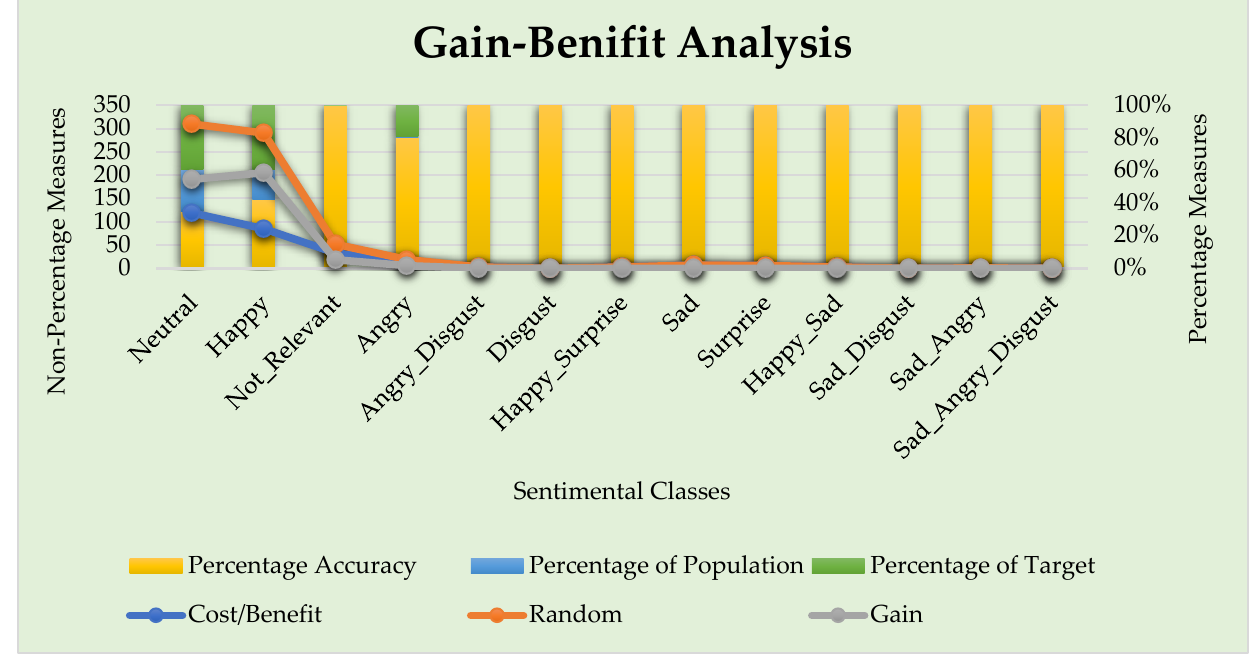
Figure 12. Graphical representation of cost/benefit (tetrad feature selection techniques). Table 12 first part indicates the threshold plot curve ratio between the sample size (X) and the true positive rate (Y) from 0 to 1. The second part indicates the cost/benefit curve between the sample size (X) and the cost/benefit (Y) clusters with an acceptable accuracy rate. In the last column, cost curve represents the ratio between the probability cost function (X) and the normalized expected cost (Y). Table 12. Cost/benefit summary for pure and compound sentiments (tetrad of feature selection tech- niques).